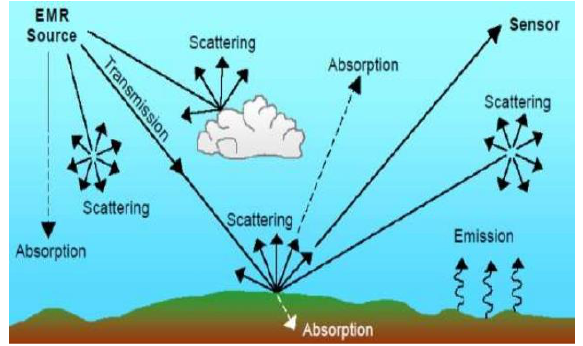
Figure 2. Electromagnetic rays and their interactions.